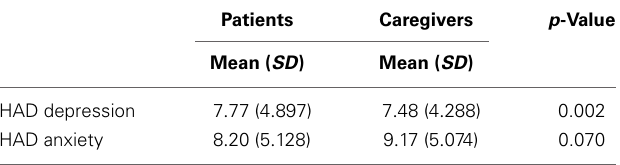
Table 3 | HADS (total score). Table 4 | Pearson correlations for depression and anxiety and general and mental